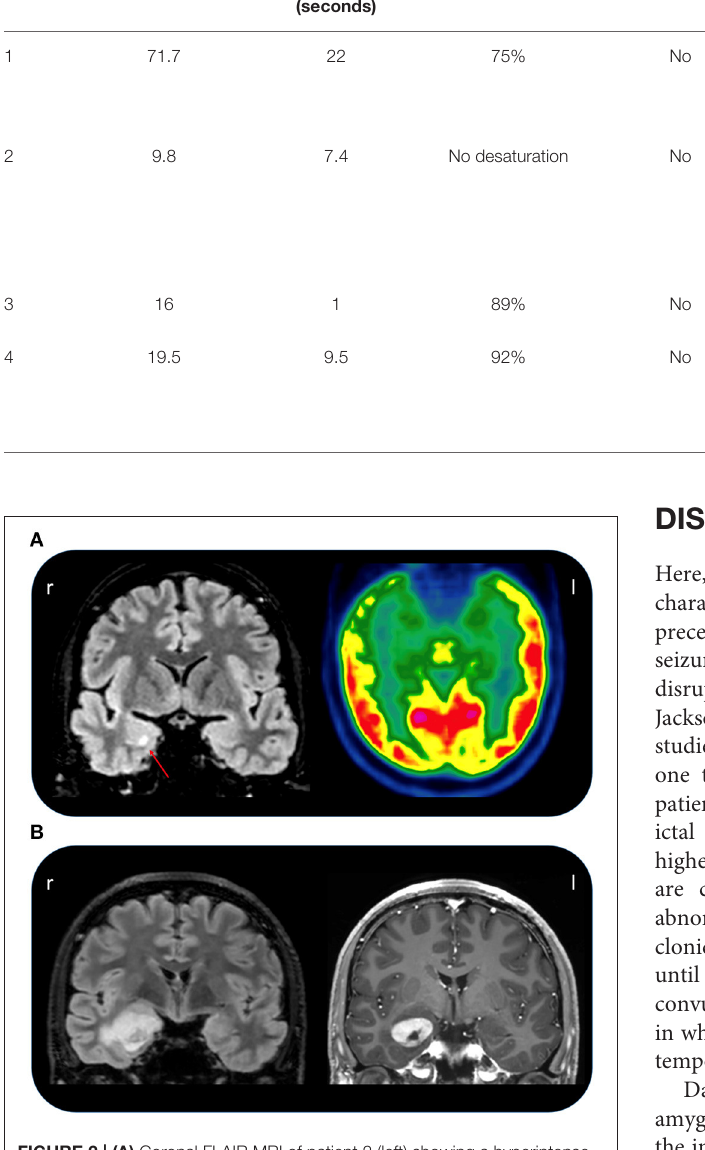
FIGURE 2 | (A) Coronal FLAIR MRI of patient 2 (left) showing a hyperintense right amygdala with red arrow pointing to an area of increased signal intensity (red arrow). On the right, the FDG-PET image of the same patient showing right temporal hypometabolism involving the temporal pole and mesial regions. (B) Coronal FLAIR MRI of patient 4 (on the left) showing a temporo-mesial lesion that on T1 imaging (on the right) present a clear gadolinium enhancement suggesting a tumoral